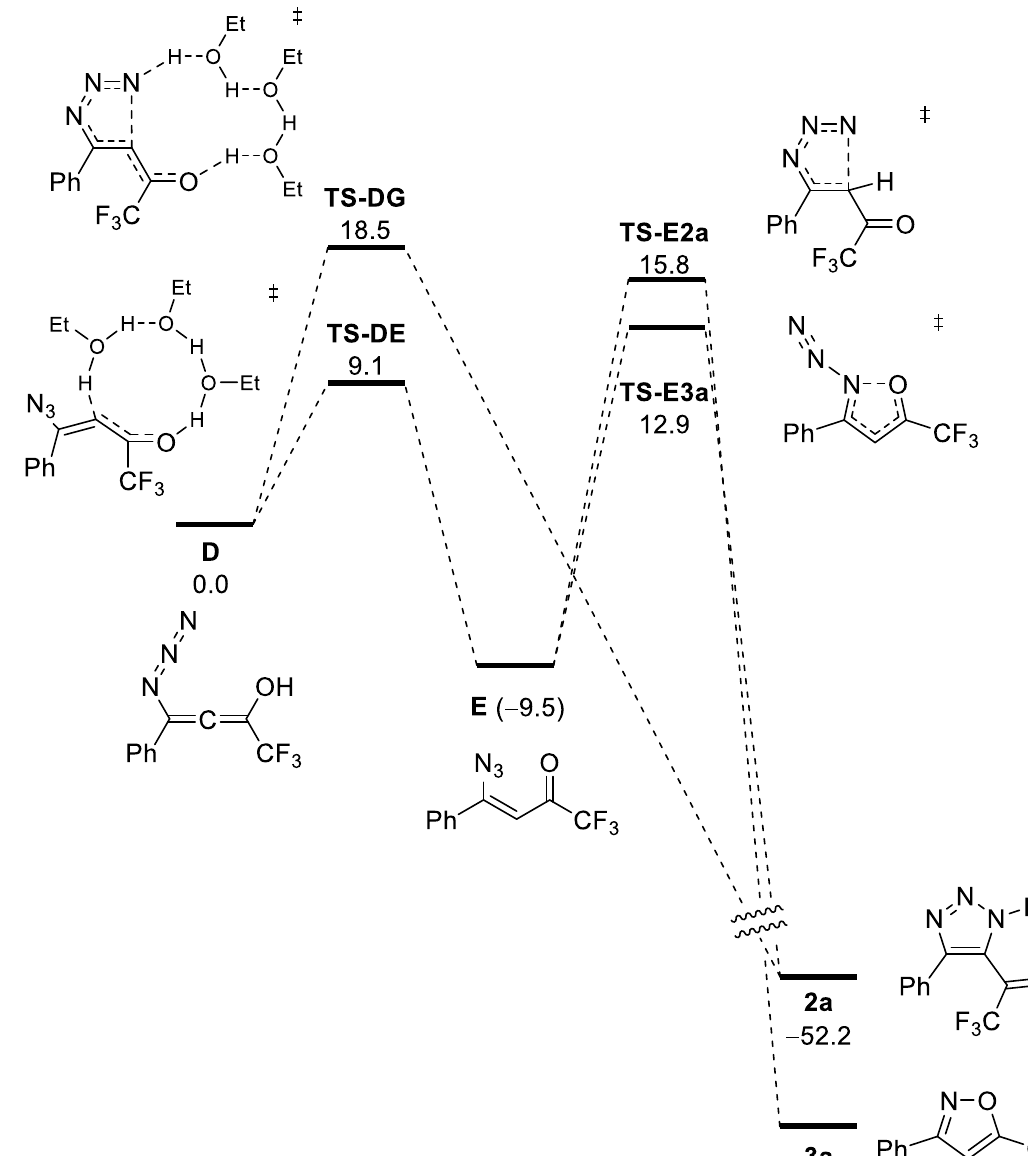
Scheme 4. Plausible DFT mechanism of formation of isoxazoles in presence of acid (numbers are relative Gibbs free energies in